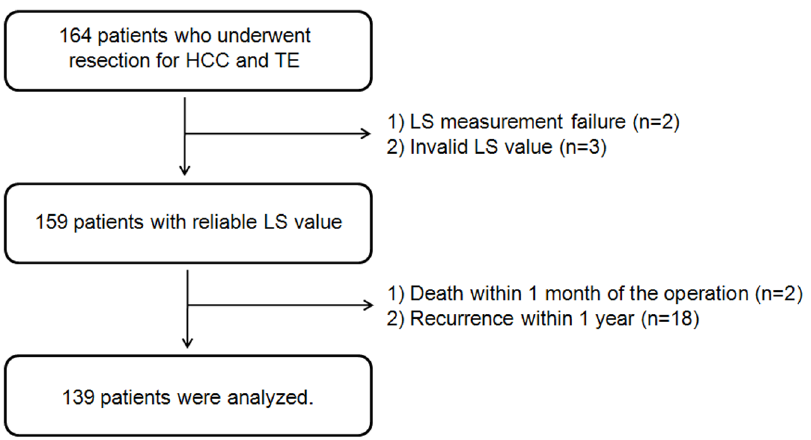
Figure 1. Flow chart of patient selection. A total of 164 patients with HCC undergoing curative resection were recruited. Five patients were excluded due to LS measurement failure or an unreliable LS measurement. Of the 159 patients with a reliable LS value, 20 were excluded due to postoperative death within 1 month, or early recurrence within 1 year. Thus, a total of 139 patients were selected for statistical analysis. HCC, hepatocellular carcinoma; LS, liver stiffness measurement.